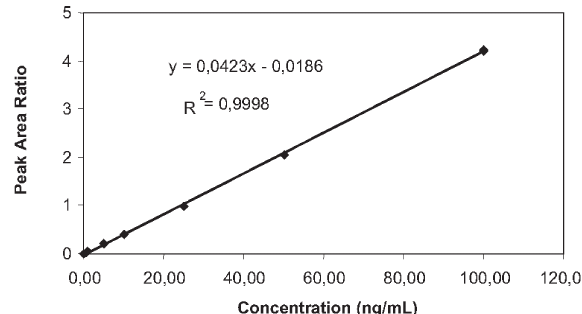
Figure 3. Calibration daily curve of propranolol in plasma, blank plasma spiked to obtain six concentrations of